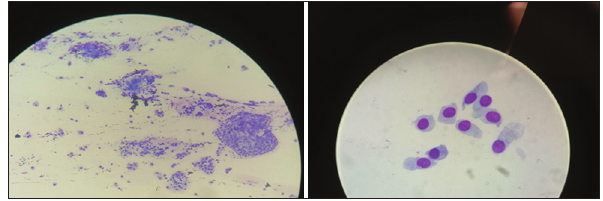
Figure-8: Cytobrush cytology sample-to the left 20× magnification, to the right 100× magnification.